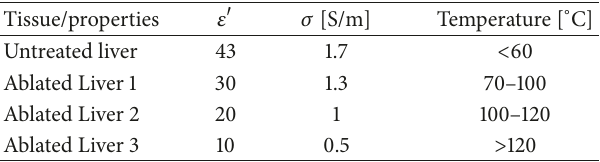
Table 1: Electromagnetic properties of the ablated tissues, seg- mented from